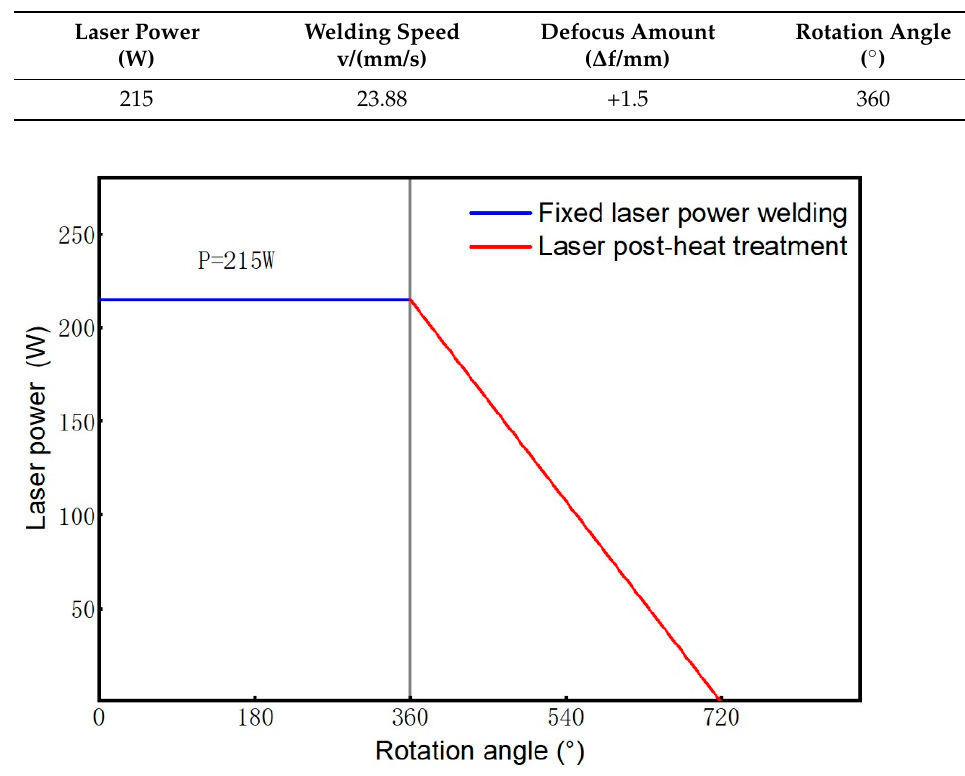
Figure 3. Schematic diagram of the process of laser power reduction.